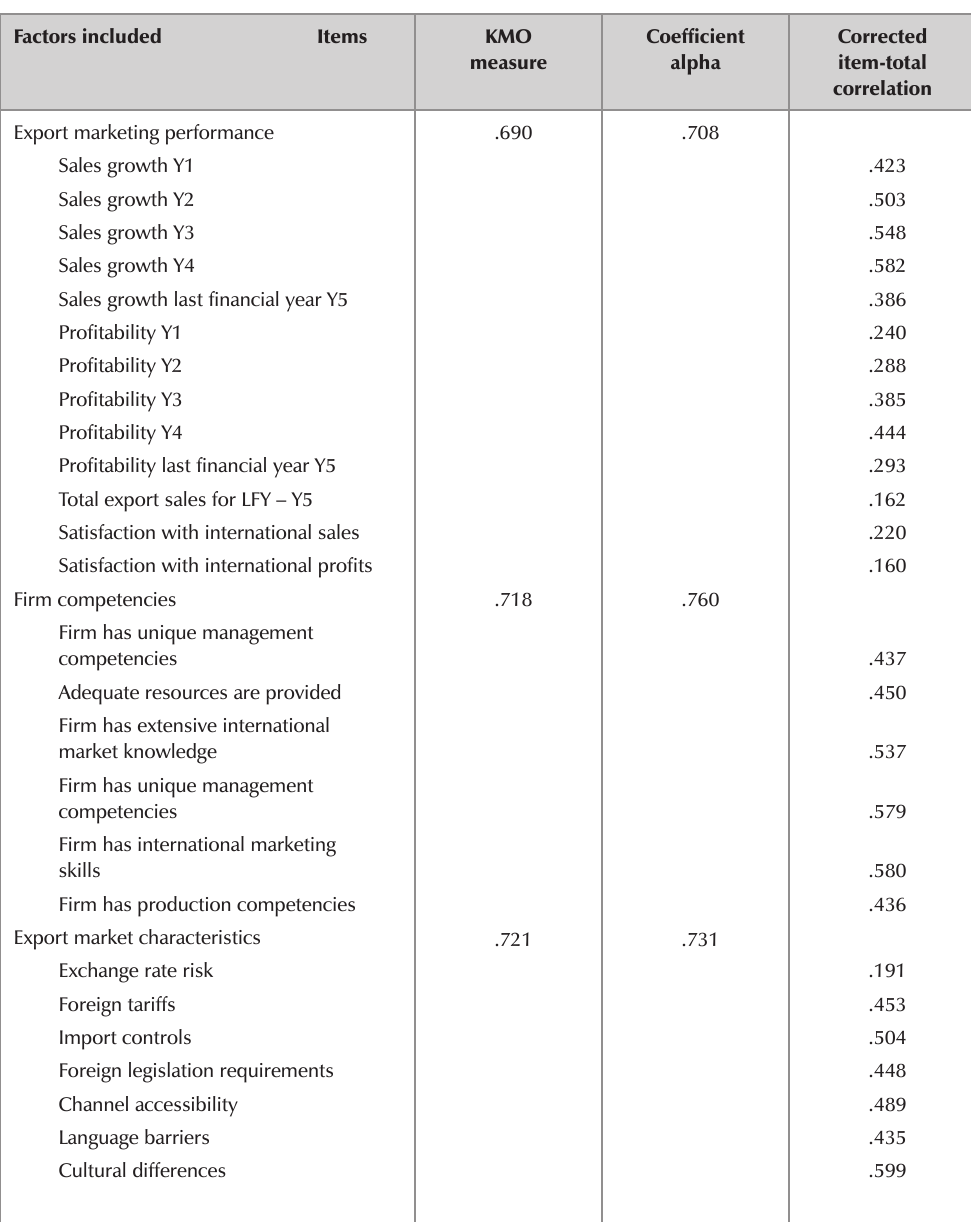
Purified measurement